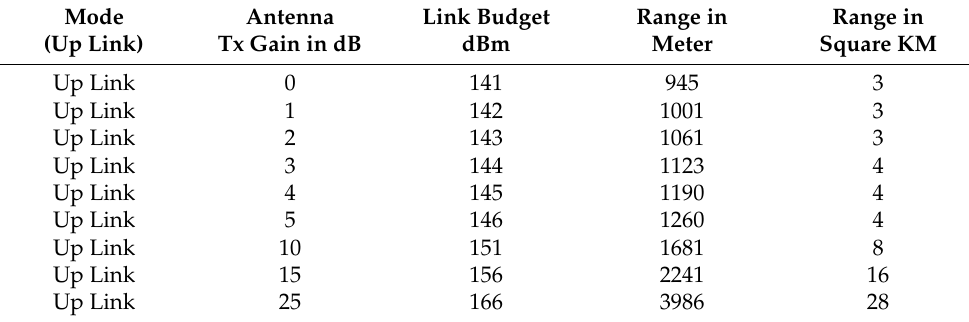
Table 7. Link budget in dBm from 141 to 164 dBm for the transmitter LoRa module.